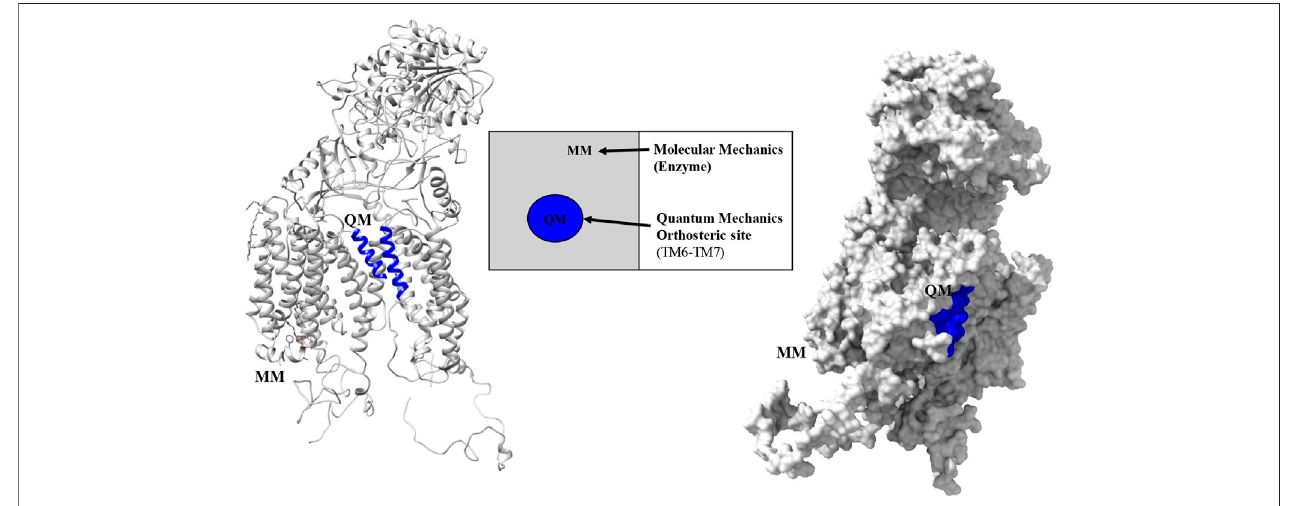
FIGURE 1 | Partition regions observed with the QM-MM hybrid method for PS1 protein in the γ -secretase